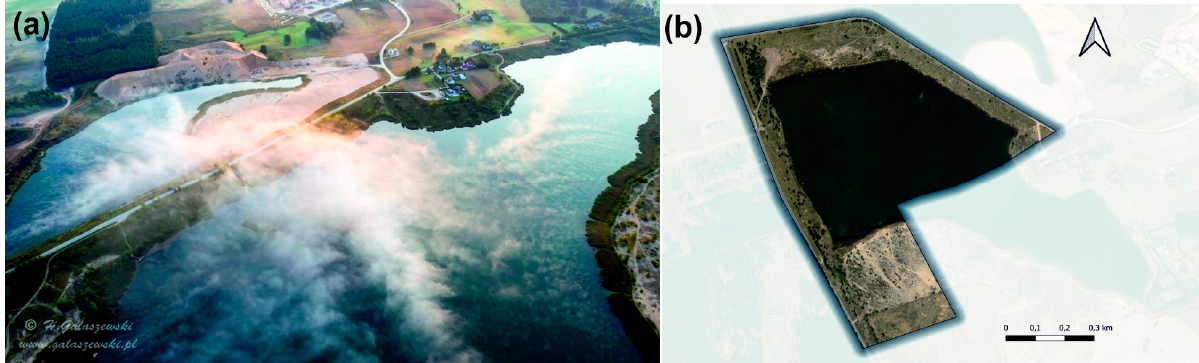
Figure 6. Bird’s ‐ eye view of the water reservoir at Sobolewo ( a ). Source: Ga ł aszewski H. Current land development in the Figure 6. Bird’s-eye view of the water reservoir at Sobolewo ( a ). Source: Gałaszewski H. Current land development in the area under study—orthophoto ( b ). Source: geoportal.gov.pl. area under study—orthophoto ( b ). Source: